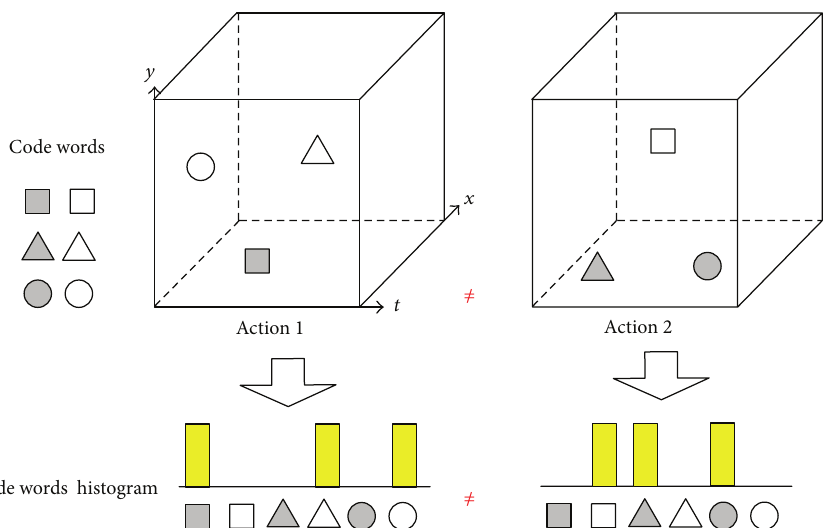
Figure 2: The illustration of our method. The shape of code words indicates appearance information, while the color indicates spatiotemporal position. For example, the code words ◼ ◻ have same appearance but different position. They are considered as two different code words in feature coding. Then, two different code words histograms are obtained for two actions upon these code words. Hence, Actions 1 and 2 which cannot be distinguished in BoF (Figure 1) can be correctly classified with our